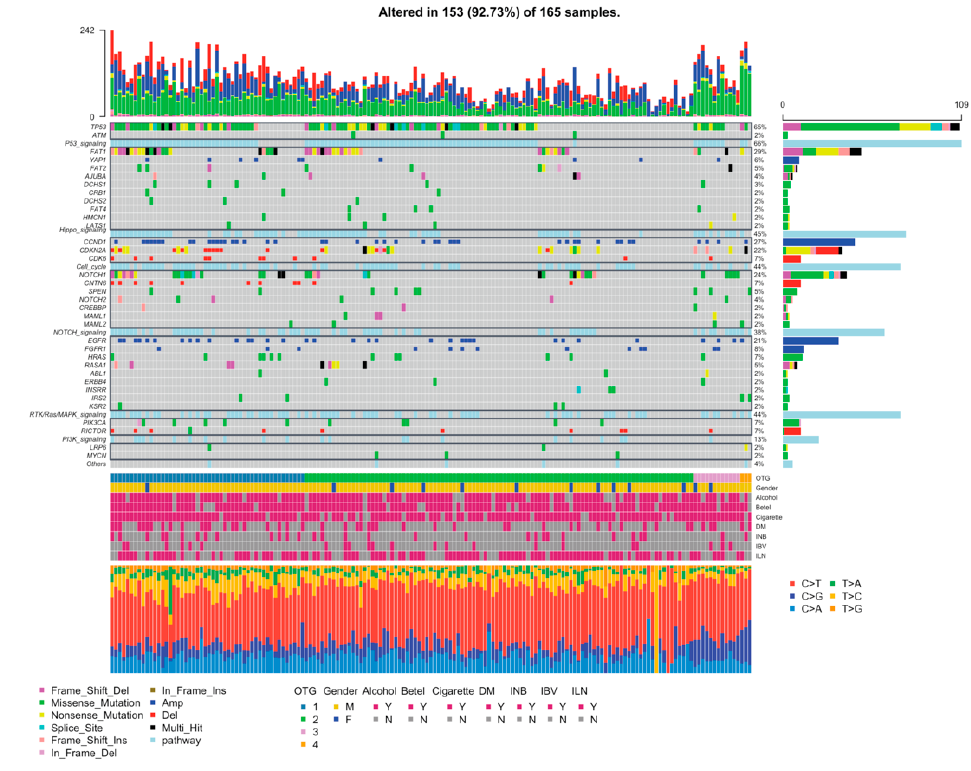
Figure 2. Significantly and frequently mutated genes in 165 oral cavity squamous cell carcinoma (OCSCC) samples detected by exome sequencing. Each column represents one OCSCC sample and each row represents the overall survival status or mutated genes of each sample. A total of 165 OCSCCs are described here, and oncogenic pathways to which each gene belongs are shown on the left.